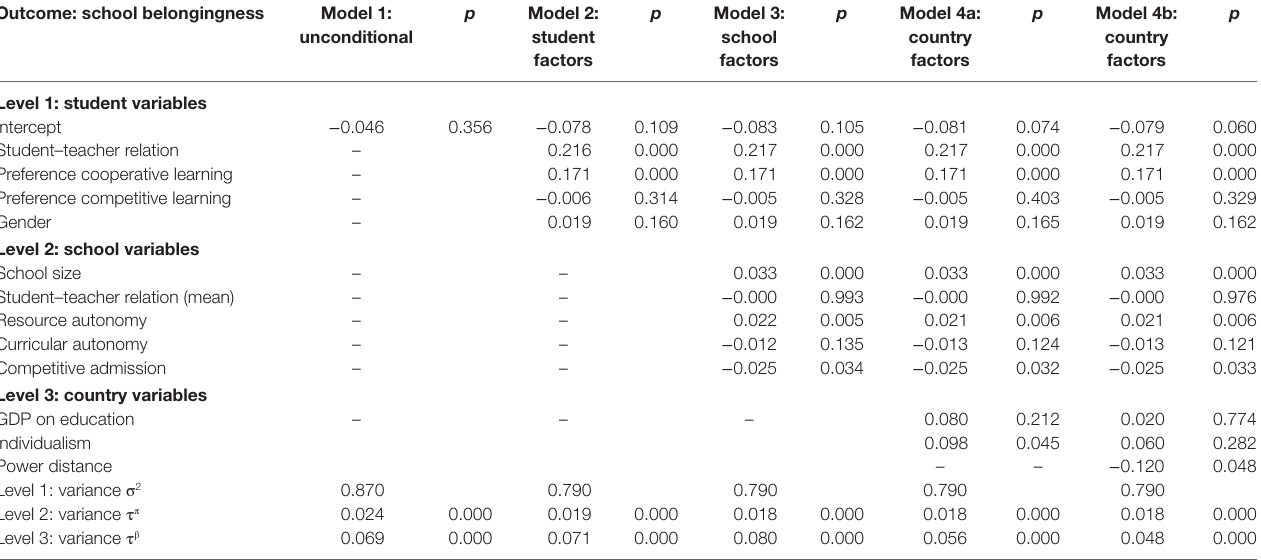
TaBle 2 | Predictors of school belongingness. Outcome: school